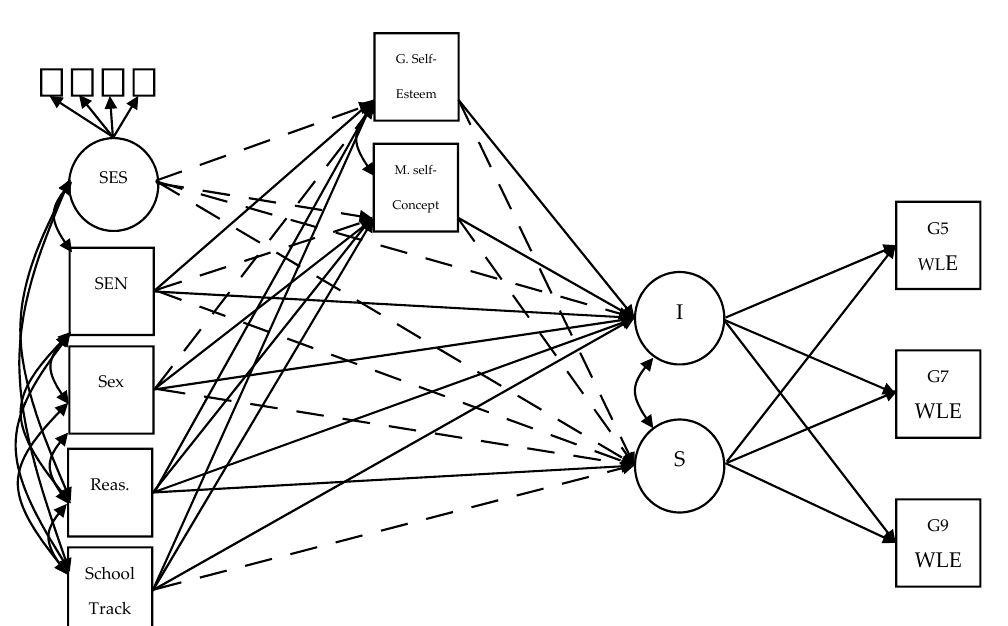
Figure 3. Mediation Model—Math. This figure describes all pathways used in the mediation model. The no mediation model was calculated by zeroing out regressions from and onto the mediators. Solid lines indicate significant paths, and dashed lines indicate non-significant paths. G5 WLE, G7 WLE, and G9 WLE refer to grade 5, 7, and 9 weighted likelihood estimates (WLE), respectively. I refers to intercept. S refers to slope. M. Self-Concept refers to math self-concept. G. Self-Esteem refers to global self-esteem. SES refers to socioeconomic status. SEN refers to special education needs. Reas. refers to nonverbal reasoning scores.